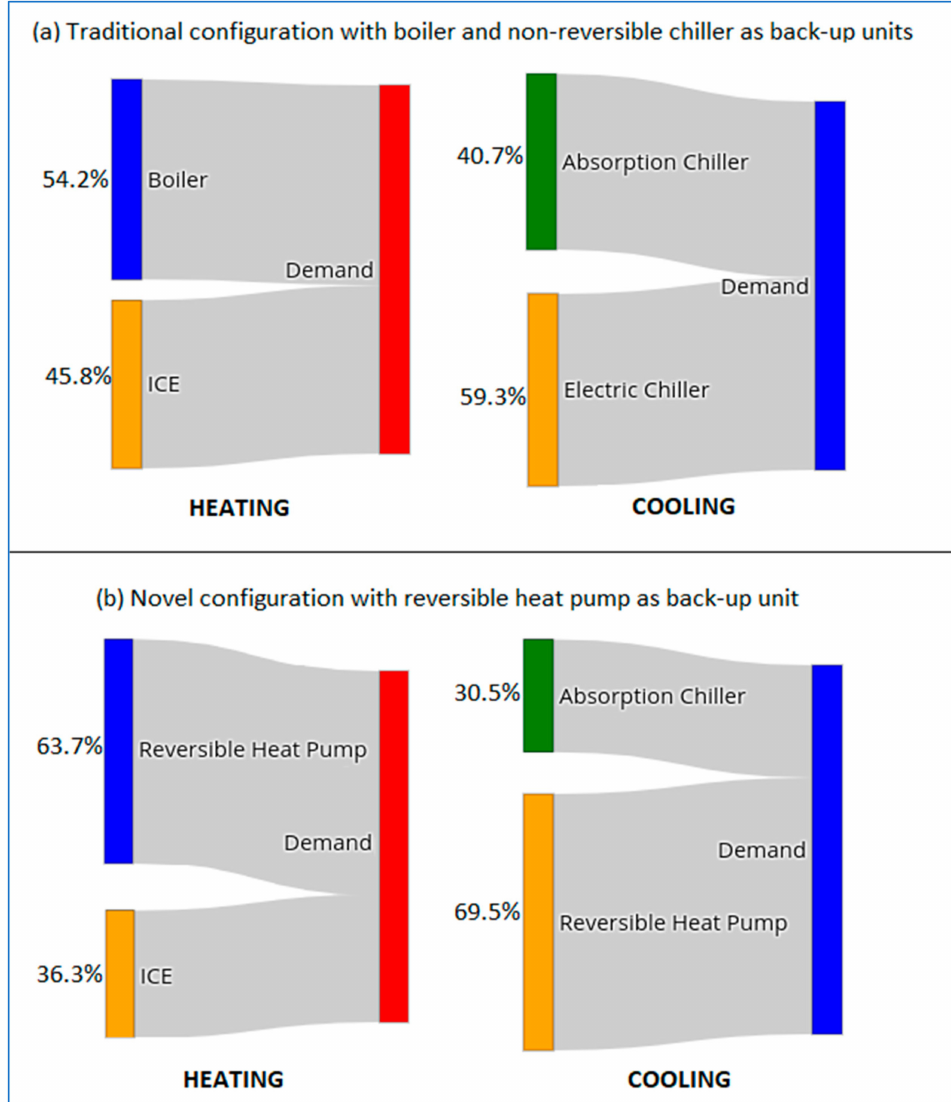
Figure 7. Sankey diagrams of the annual thermal energy balances for ( a ) traditional and ( b ) novel